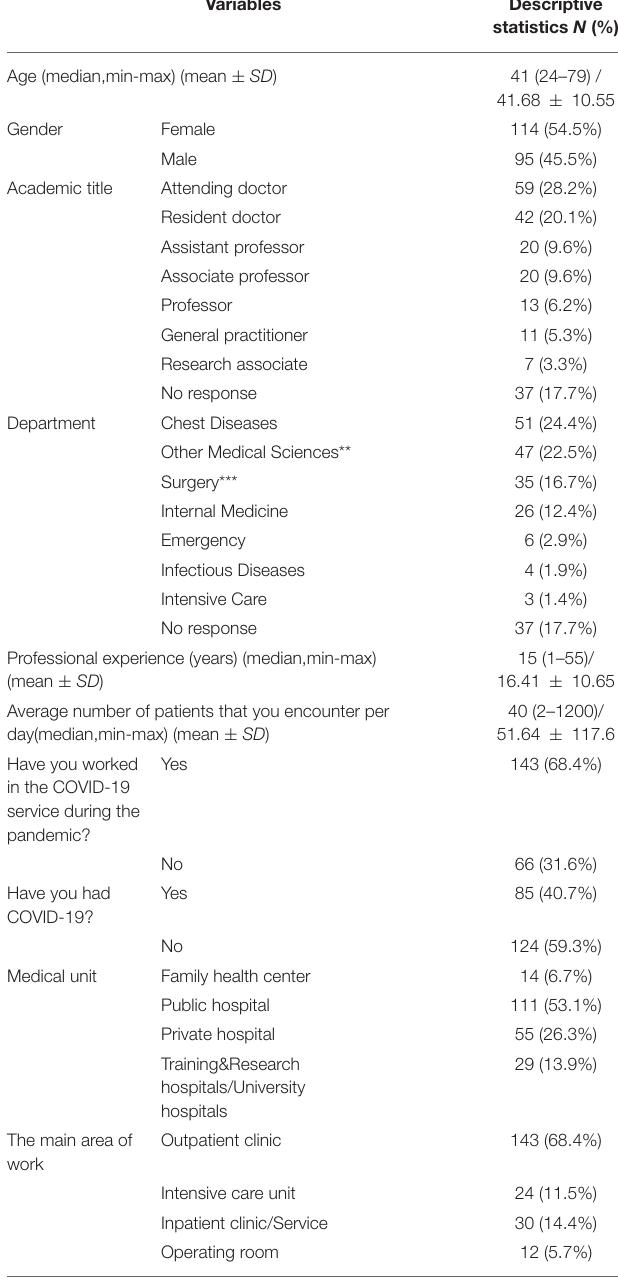
TABLE 1 | Distribution of demographical and COVID-19 related characteristics. Variables Descriptive statistics N